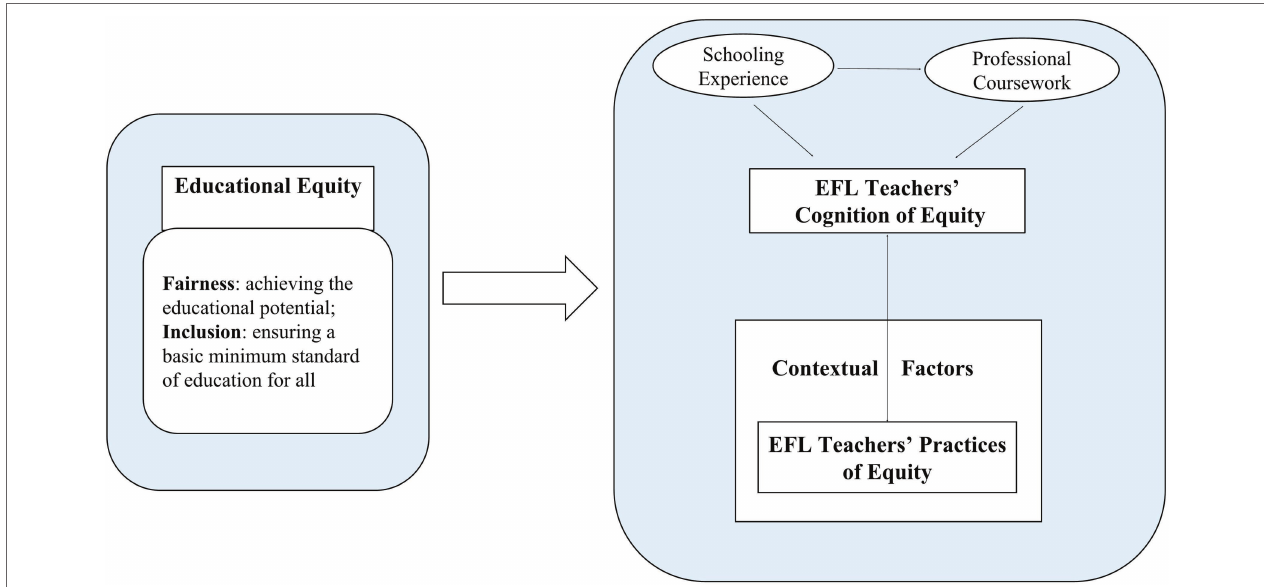
FIGURE 2 | Interrelationship among educational equity, EFL teacher’s cognition, and practices (adapted from Borg, 2003; OECD,